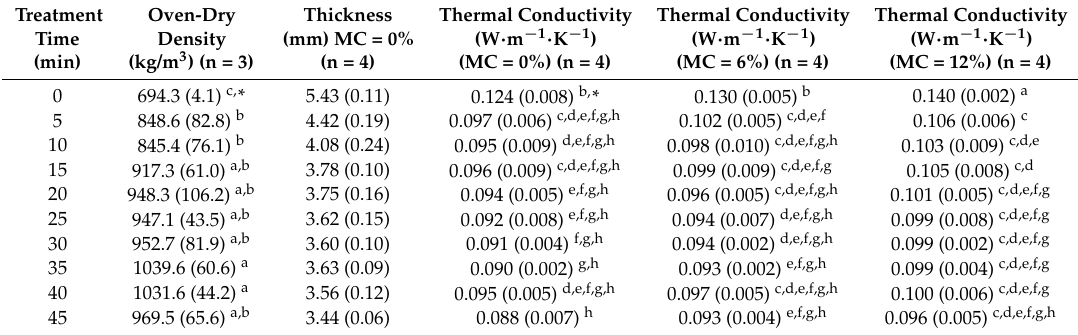
Table 6. Thermal conductivity of the control and samples densified at different time. Treatment